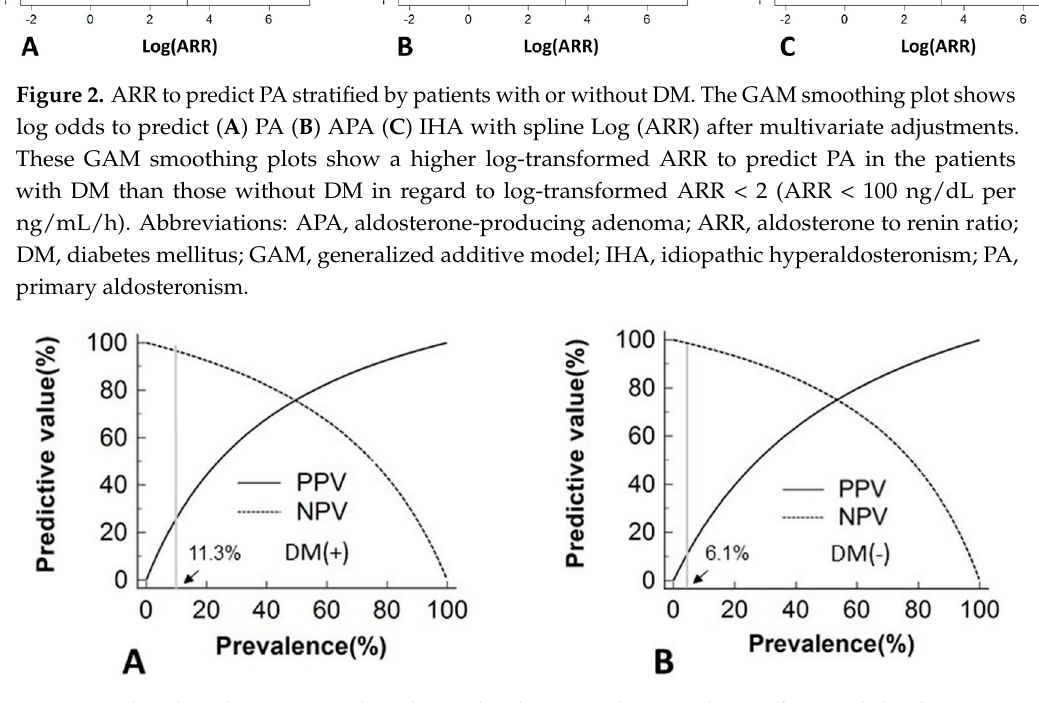
Figure 3. The plots demonstrate the relationship between the prevalence of PA and the diagnostic accuracy of the cut-off value as 65 ng/dL per ng/mL/h in patients with DM ( A ) and 45 ng/dL per ng/mL/h in patients without DM ( B ). The light gray line represents the reported PA prevalence of 11.3% in the hypertensive population with DM, and 6.1% in the hypertensive population without DM. Abbreviations: DM, diabetes mellitus; NPV, negative predictive value; PA, primary aldosteronism; PPV, positive predictive value.